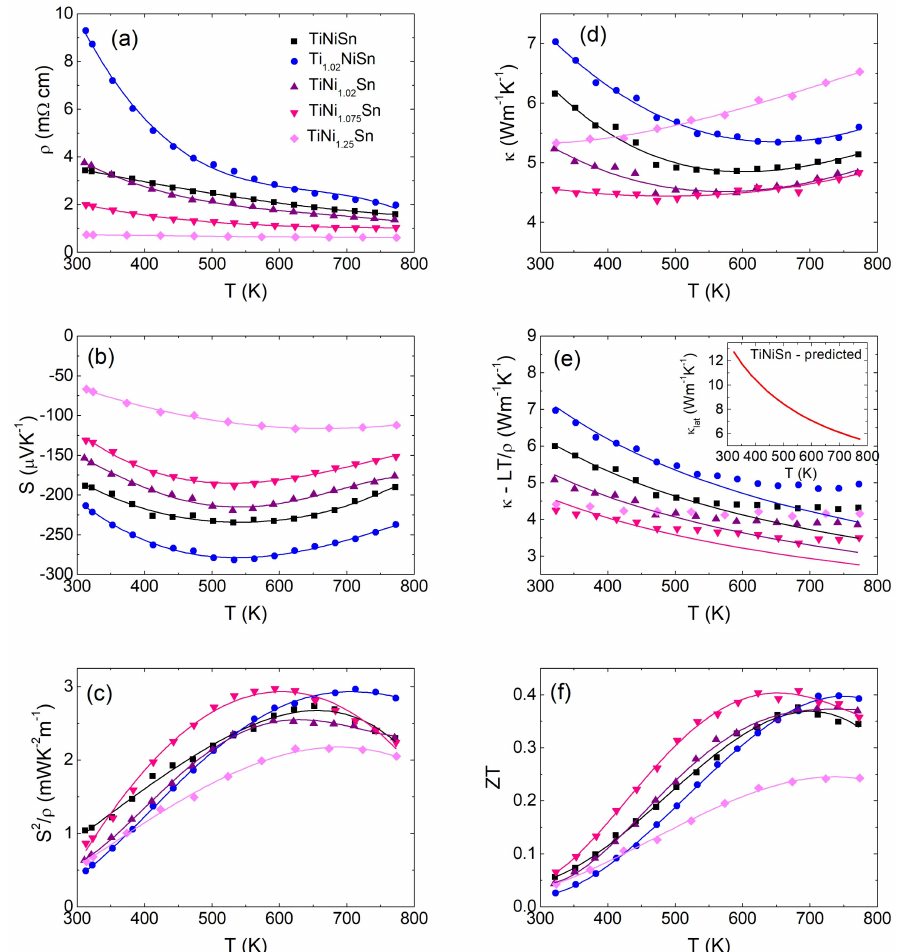
Figure 5. Temperature dependence of ( a ) the electrical resistivity ( ρ ), ( b ) the Seebeck coefficient (S), ( c ) the thermoelectric power factor (S 2 / ρ ), ( d ) the total thermal conductivity ( κ ), ( e ) the lattice thermal conductivity ( κ -LT/ ρ ) and ( f ) the figure of merit (ZT) for the TiNi 1+y Sn samples and Ti 1.02 NiSn. The solid lines in panel (e) are Debye–Callaway fits in the 323–523 K interval. The inset to panel (e) shows the predicted κ lat for stoichiometric